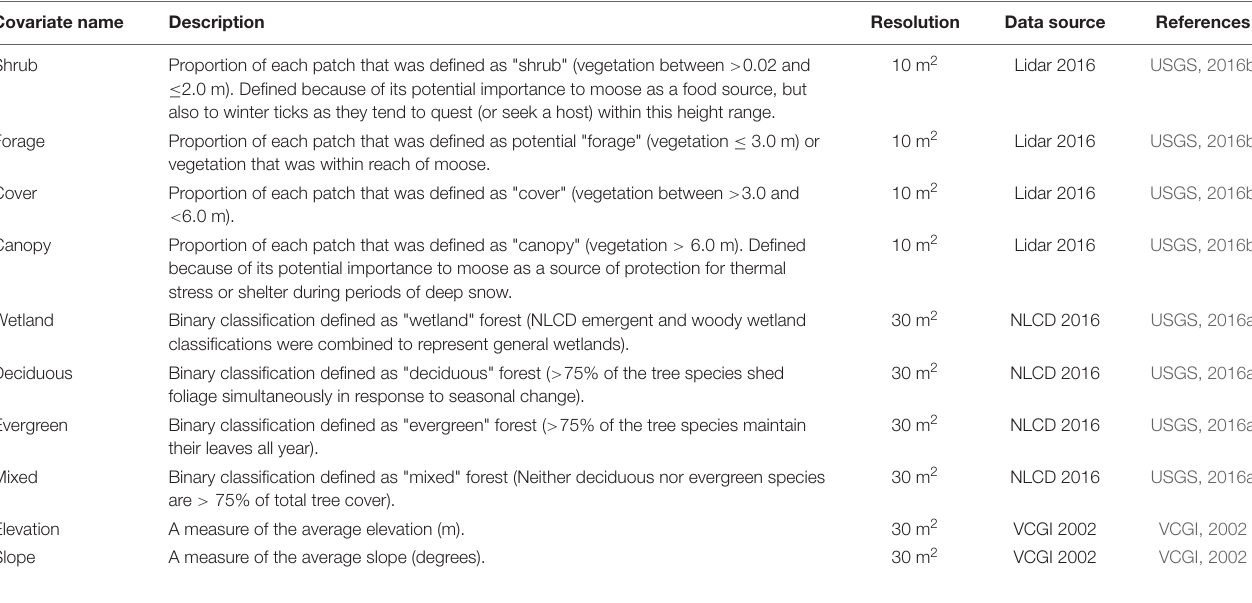
TABLE 1 | Covariates used to develop multi-season occupancy models for moose ( Alces alces) in northeastern Vermont, United States. Covariate